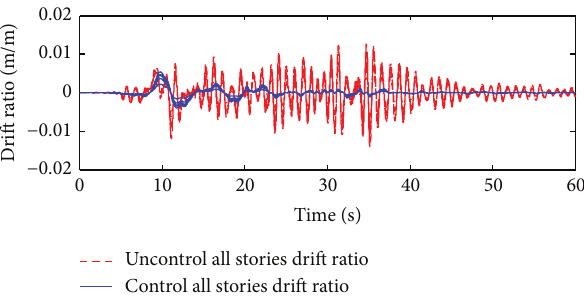
Figure 15: Drift ratio of all five floors for uncontrolled and synchronized control coupled with 𝐻 2 / LQG algorithm in Bam